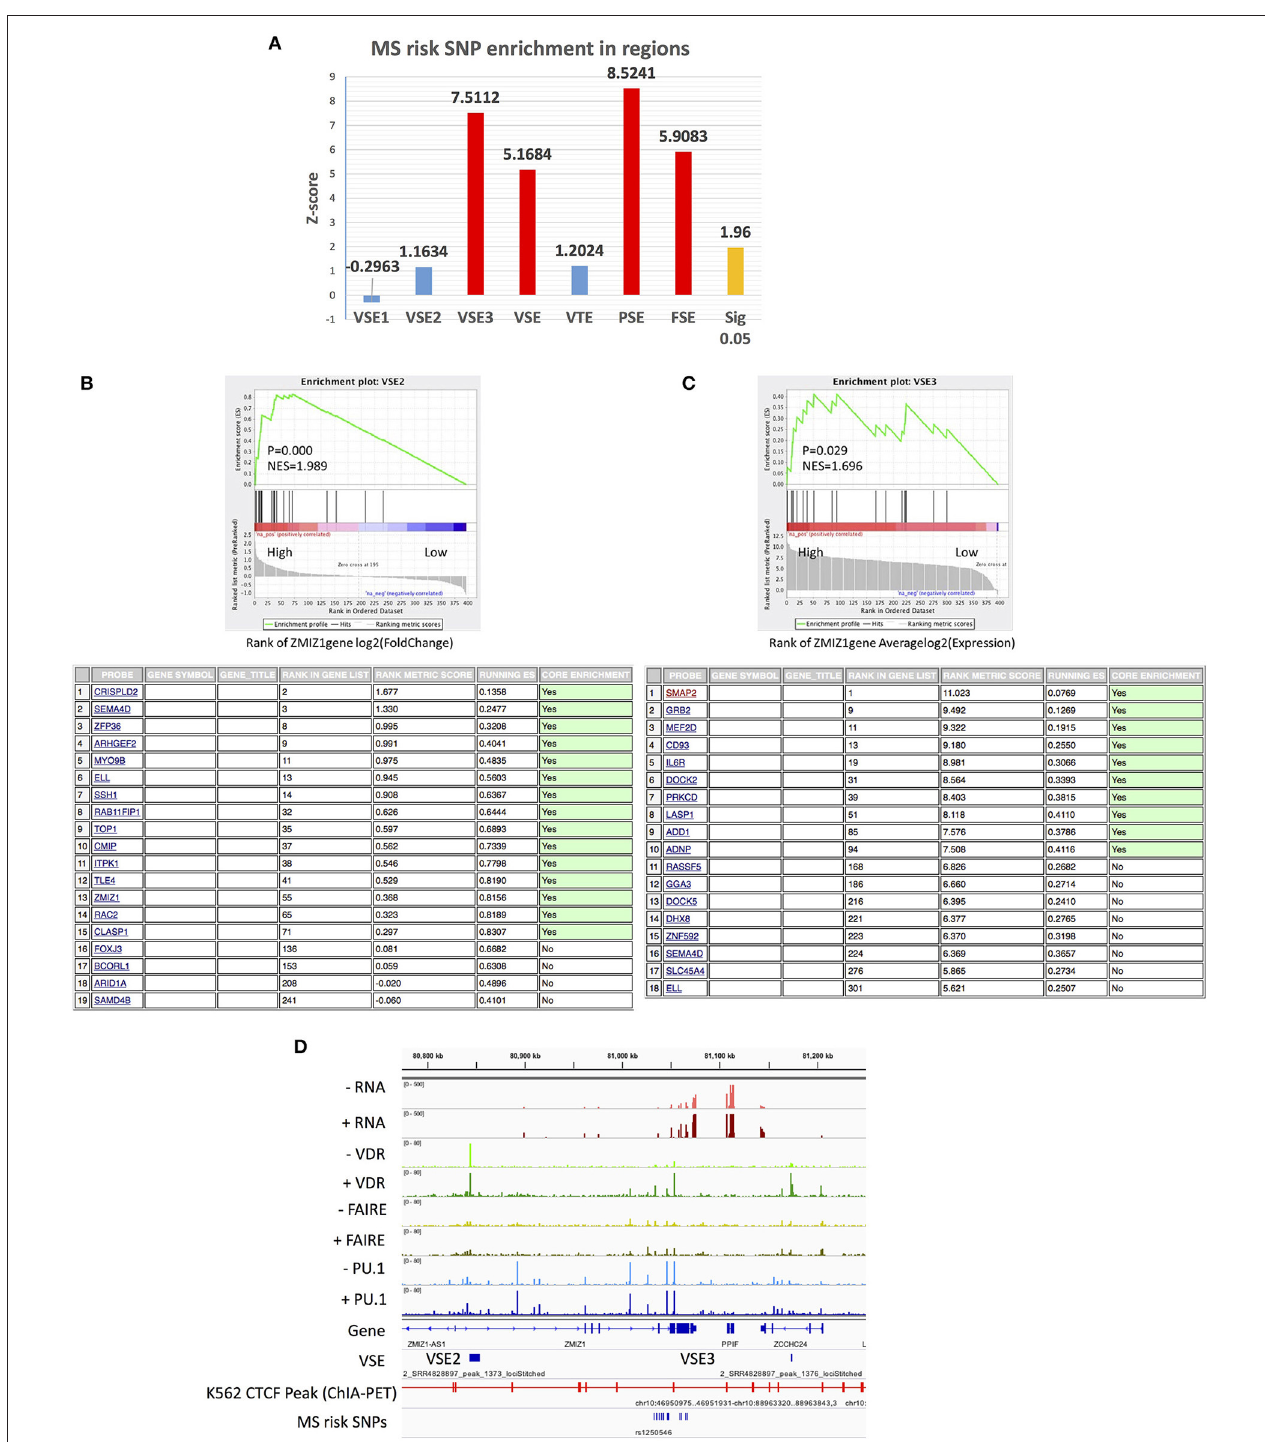
FIGURE 4 | The association of MS risk SNPs and ZMIZ1 gene set with VSE. (A) MS risk SNP enrichment in different SE regions. (B) VSE2-regulated genes are enriched in ZMIZ1 positively associated genes with higher log 2 (fold change) (above); The names of these enriched VSE2-regulated genes (below). (C) VSE3-regulated genes are enriched in ZMIZ1 positively associated genes with higher average log 2 (expression) (above); The names of these enriched VSE3-regulated genes (below). (D) Visualization of signal densities and VSE region around ZMIZ1 gene.